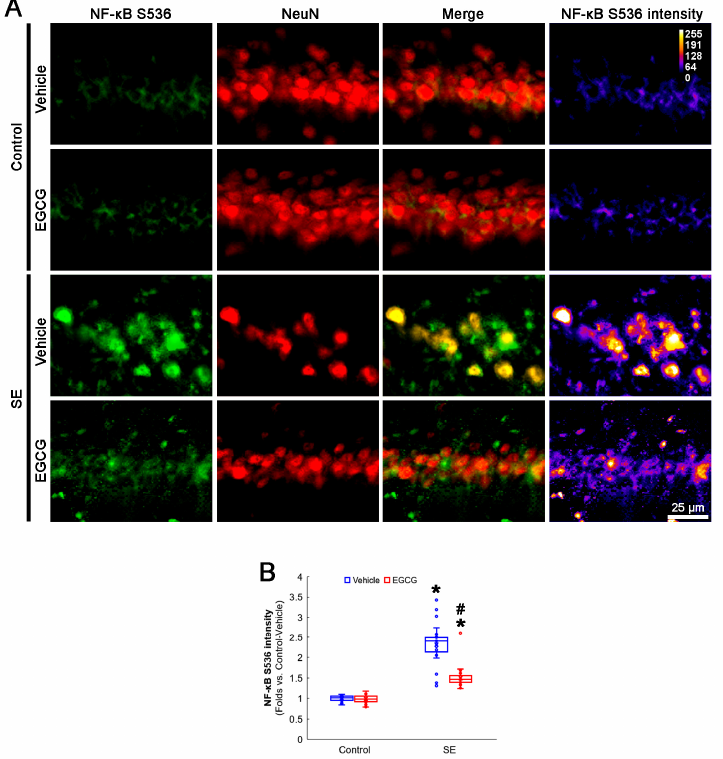
Figure 7. Effects of EGCG on NF- κ B S536 phosphorylation in CA1 neurons following SE. Compared with control animals, NF- κ B S536 phosphorylation was augmented in CA1 neurons of SE group. In control animals, EGCG did not a ff ect NF- κ B S536 phosphorylation level. EGCG a tt enuated NF- κ B S536 phosphorylation in CA1 neurons of SE group. ( A ) Representative photos of NF- κ B S536 phos- phorylation level and its intensity. ( B ) Quanti fi cation of NF- κ B S536 intensity in CA1 neurons (* and # p < 0.05 vs. control and vehicle-treated animals; n = 35 cells in 7 rats, respectively).